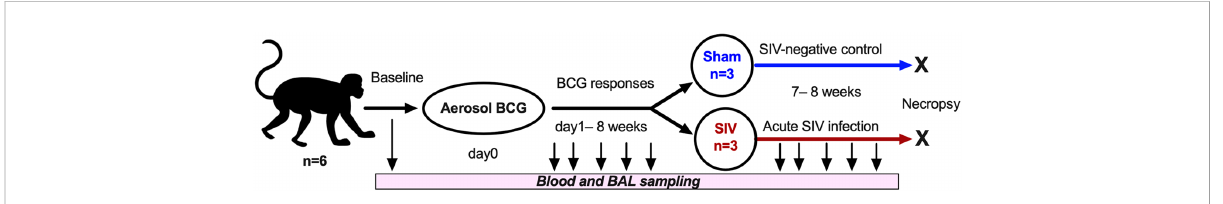
FIGURE 2 Study Design. Cynomolgus macaques (CM, n=6) were inoculated via aerosol exposure with a target dose of 1,000 CFU of M. bovis BCG (Danish). Serial collections of blood were obtained at several study timepoints, including d0, d1, and then weekly post-BCG inoculation till necropsy. SIVmac251 was inoculated intravenously into 3 test animals and 3 control animals received saline injection (sham) at 8 weeks-post- BCG, and the animals underwent euthanasia at 7 weeks post-SIV challenge